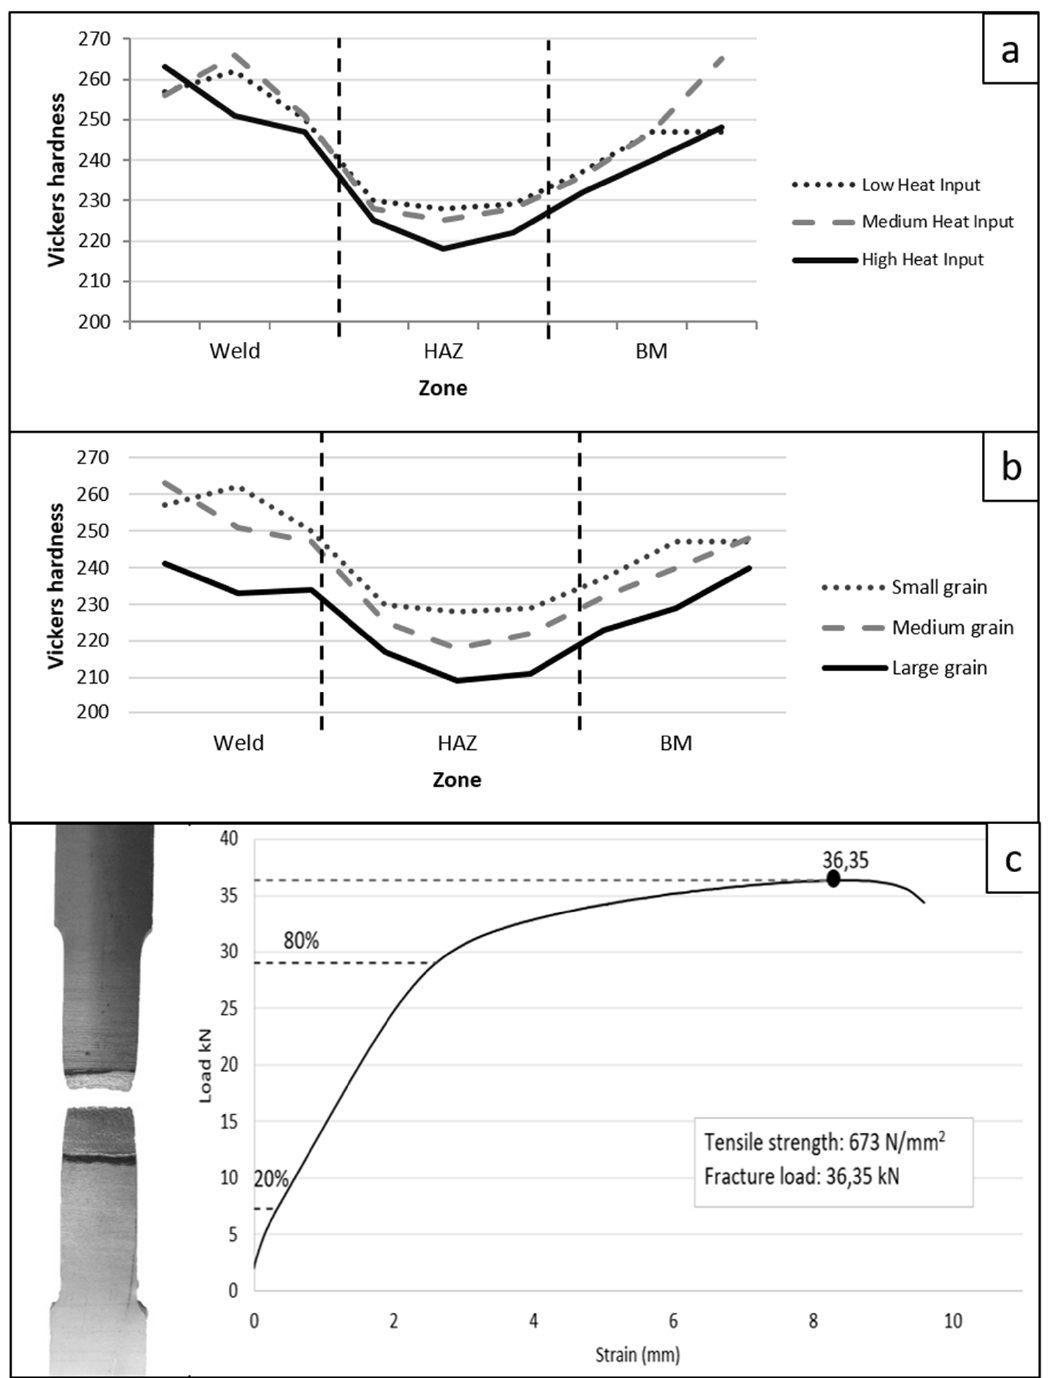
Figure 7. ( a ) Vickers hardness as a function of the heat input of material S32001. ( b ) Vickers hardness as a function of grain size, ( c ) tensile testing for coupon 7.